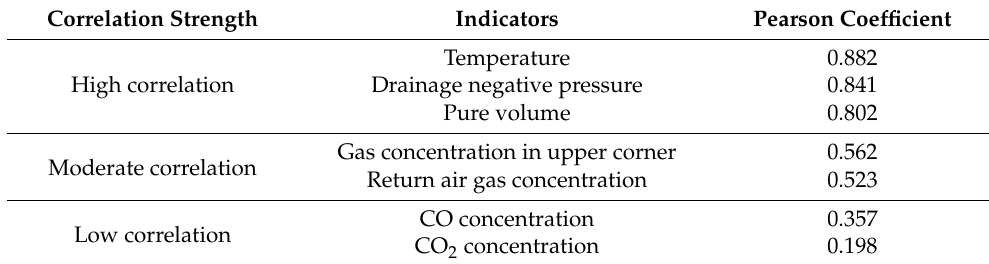
Table 1. Pearson correlation